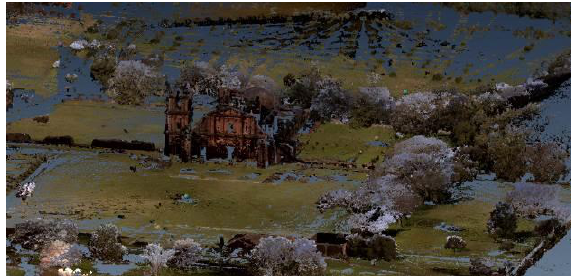
Figure 6 – Point cloud registered and georeferenced acquired from the Optec ILRIS 3D HD